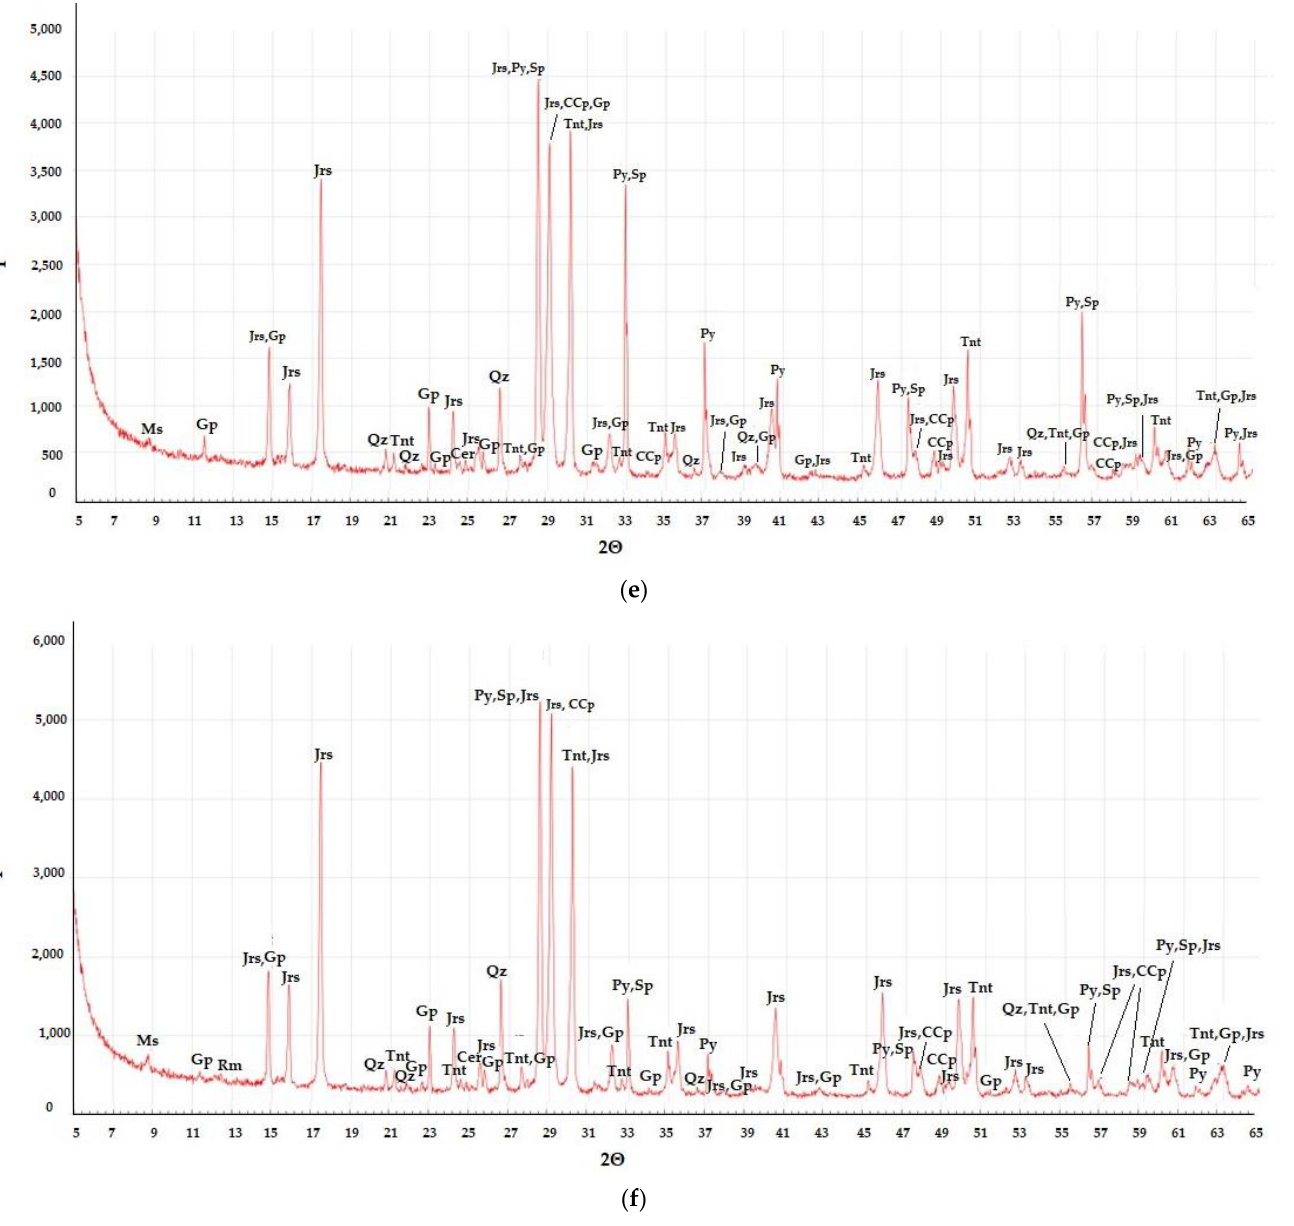
Figure 1. X-ray diffraction pattern of the samples: ( a ) concentrate; ( b ) bioleaching residue (1 mode); ( c ) bioleaching residue (2 mode); ( d ) ferric leaching residue (90 °C); ( e ) ferric leaching residue (90 °C, 0.5 M NaCl); ( f ) ferric leaching residue (90 °C, 1.0 M NaCl). Py: pyrite; Sp: sphalerite; Tnt: ten-